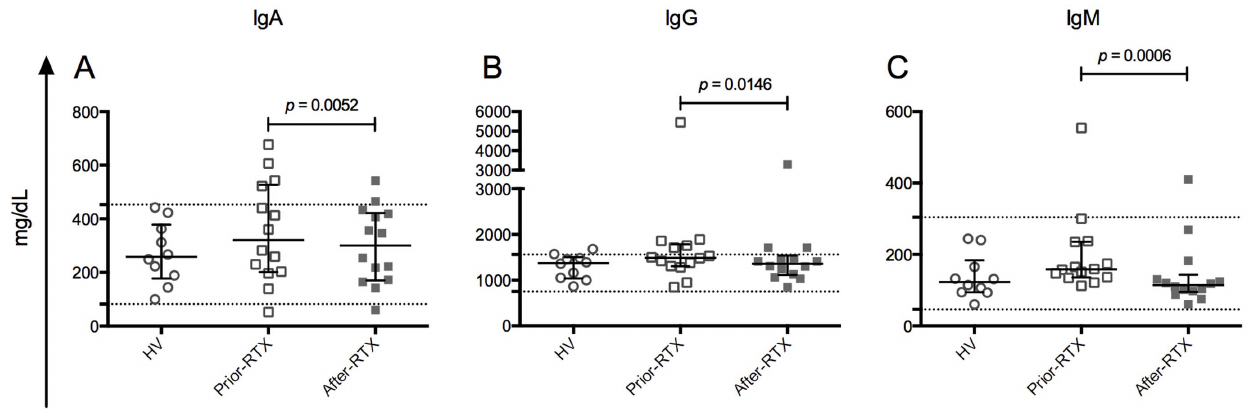
Figure 4. Comparison of total immunoglobulins in plasma among the study groups. Levels of total IgA ( A ), IgG ( B ) and IgM ( C ) in plasma determined by kinetic nephelometry. The dotted lines represent the lower and upper values of the normal reference range (IgA: 82–453 mg/dL; IgG: 751–1560 mg/dL; IgM: 46–304 mg/dL). Solid lines and error bars denote the median and interquartile range, respectively. Differences between HV (n=10) and patients prior-RTX (n=14) were evaluated with Mann–Whitney tests and between patients prior-RTX and patients after-RTX (n=14) with Wilcoxon tests. All p values reported are 2-tailed.